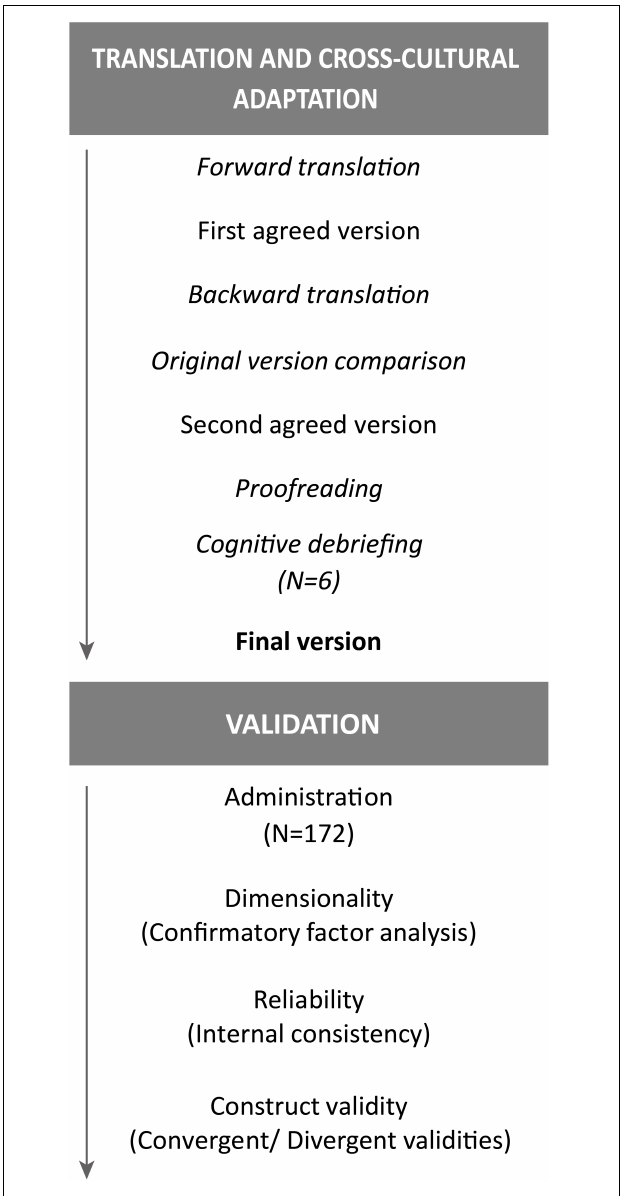
FIGURE 1 | Flowchart of the cross-cultural adaptation and validation of the Perceived Ability to Cope with Trauma (PACT).